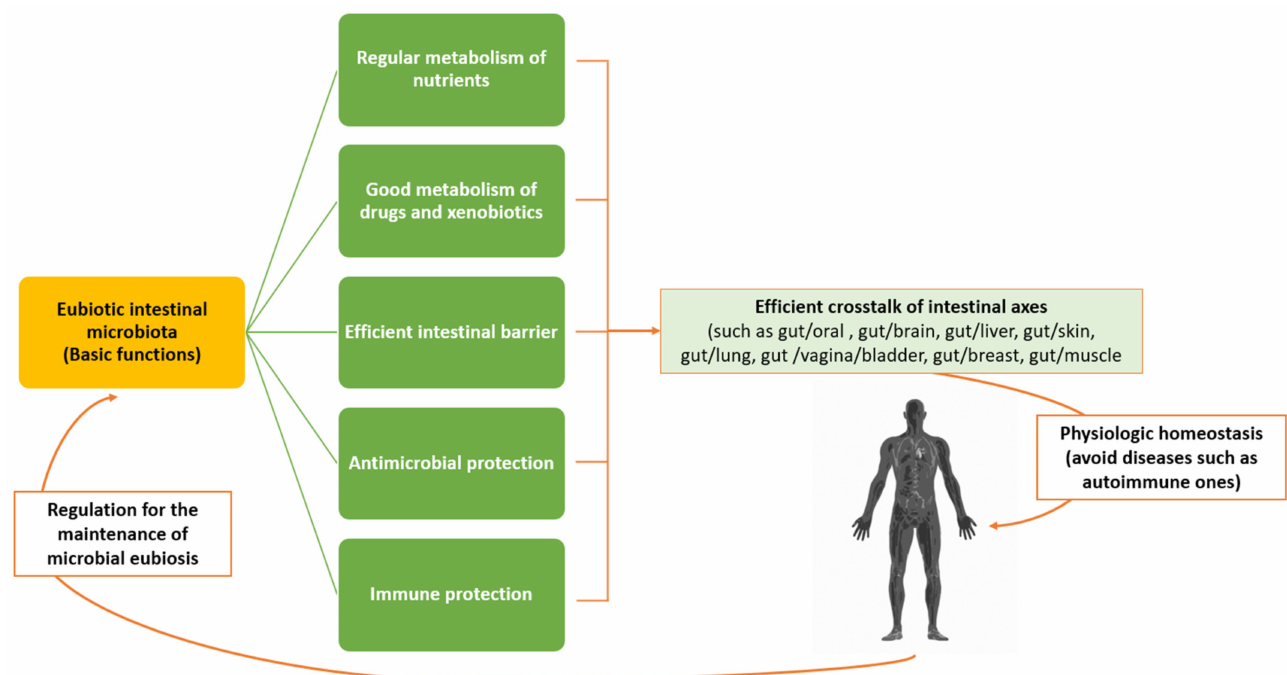
Figure 2. There exists a correlation and a crosstalk-cycle immunity regulation (CCII) between the intestinal microbiota and the various organs, thus building immune network communication pathways under the control of bacteria. In the case of eubiosis, the axes—through correct function of the friendly microbial matrix in the intestine—maintain immune homeostasis and, thus, avoid some diseases. According to the current view, a new cellular balance is considered critical for immune homeostasis: that between Tregs and their functional cells and the different Th subsets. A change in the gut microbiota (i.e., dysbiosis) can disturb this balance, resulting in de-regulation of the immune response and promotion of a variety of disease outcome. Tregs production, indeed, seems to depend on the interaction between the intestine microbiota and the immune system. This emphasizes the basic idea that different microbes lead to the differentiation of immature T cells into different subtypes. Thus, changes in the microbial components of intestinal microbiota, such as those that can occur with exposure to antibiotics, are likely to play a leading role in the case of metabolic disorders, such as obesity, metabolic syndrome, diabetes, and immune disorders [17,65,66]. Credit: Original figure by I.A.